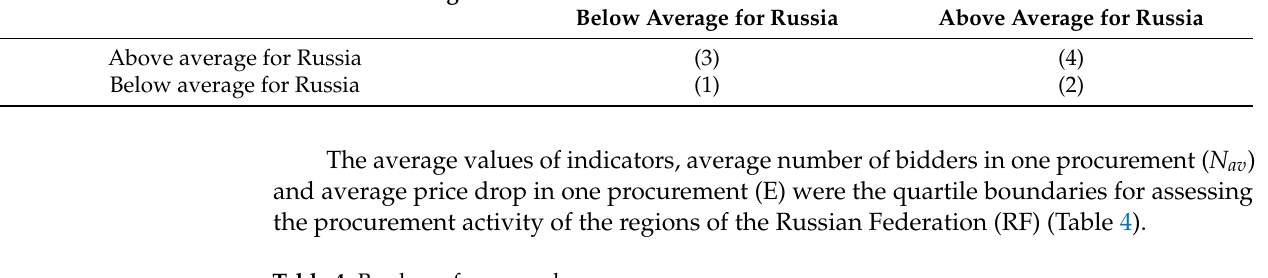
Table 3. Groups of regions regarding the connection between competition and economy. Decrease in the Initial Price for One Purchase in the Region Number of Bidders in One Purchase in the Region Below Average for Russia Above Average for Russia